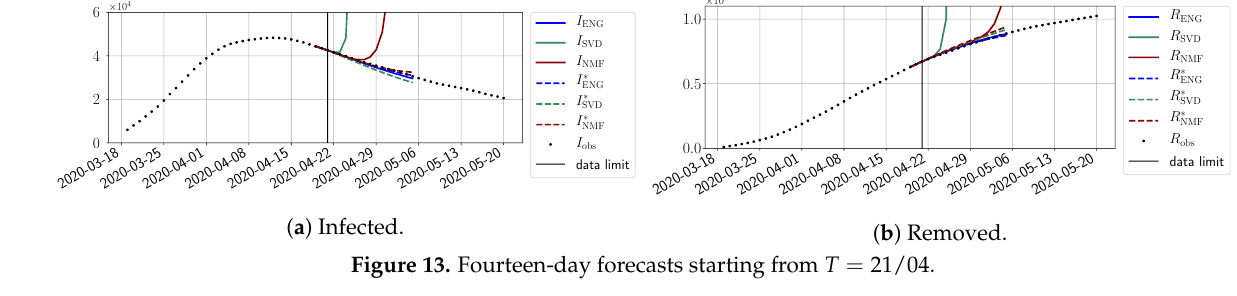
Figure 13. Fourteen-day forecasts starting from T = 21/04.